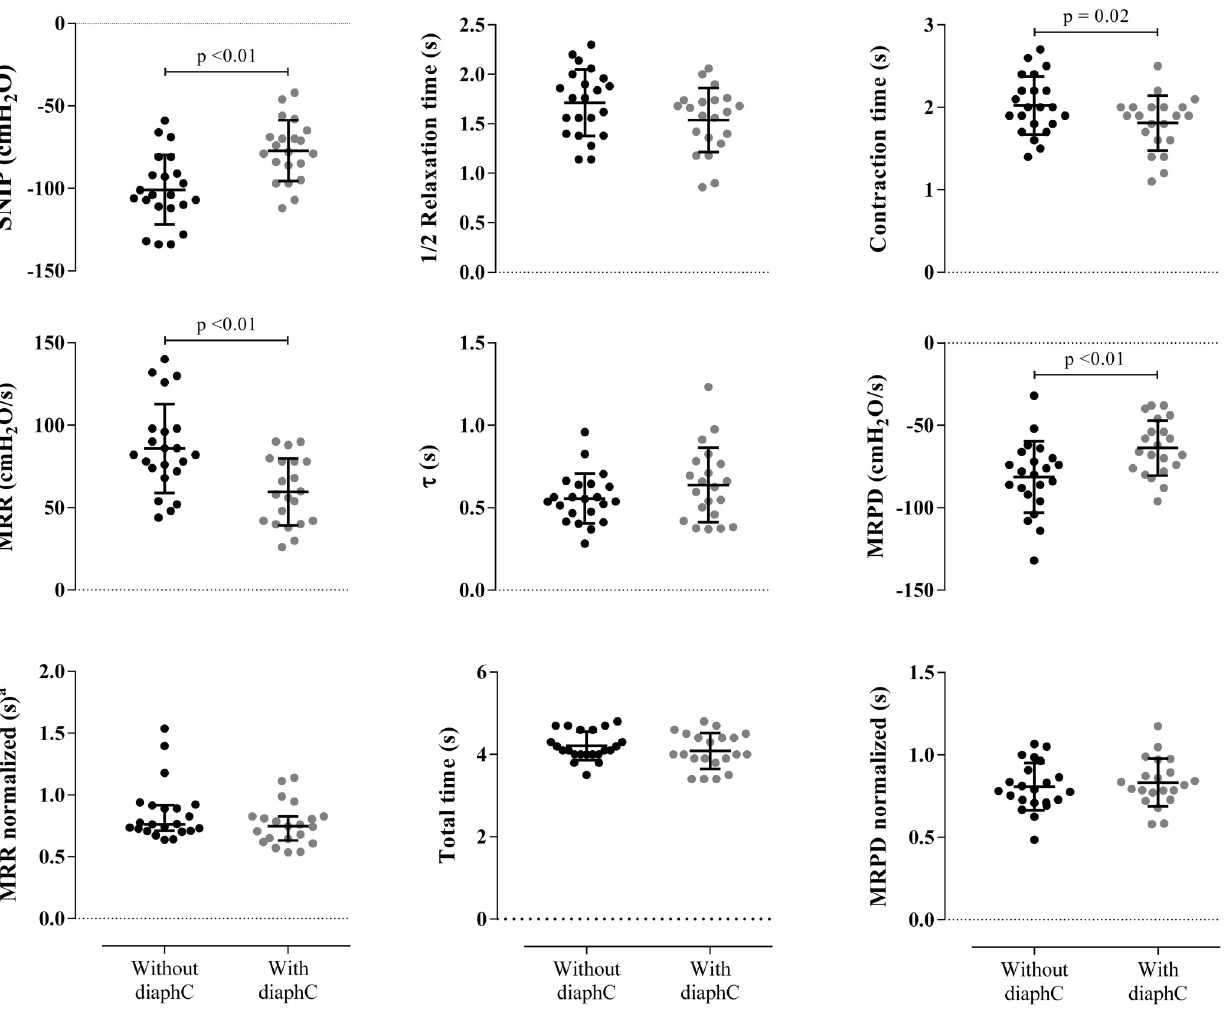
Fig 3. Multiparametric analysis. Data are shown as mean ± SD. Comparisons between maneuver with and without diaphC in the parameters obtained from the sniff nasal inspiratory pressure (SNIP) curve. MRR: maximum relaxation rate; MRPD: maximum rate of pressure development; CT: contraction time; ½ RT: half-relaxation time; τ : tau; cmH2O: centimeters of water; s: seconds.